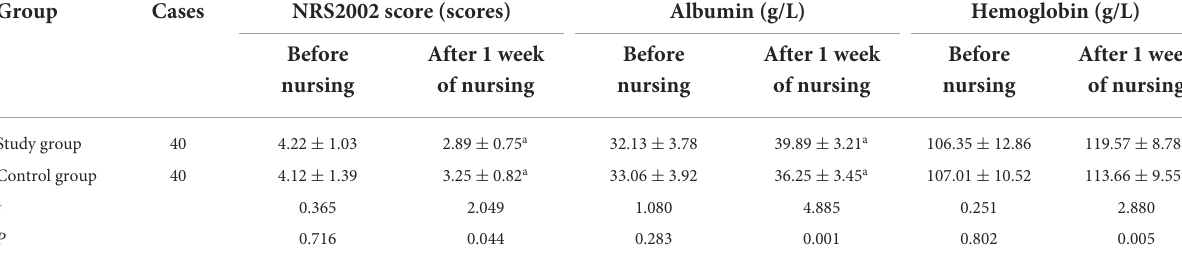
TABLE 3 Implementation effect of “Internet + medical” enteral nutrition nursing system ( ¯ x ± s).